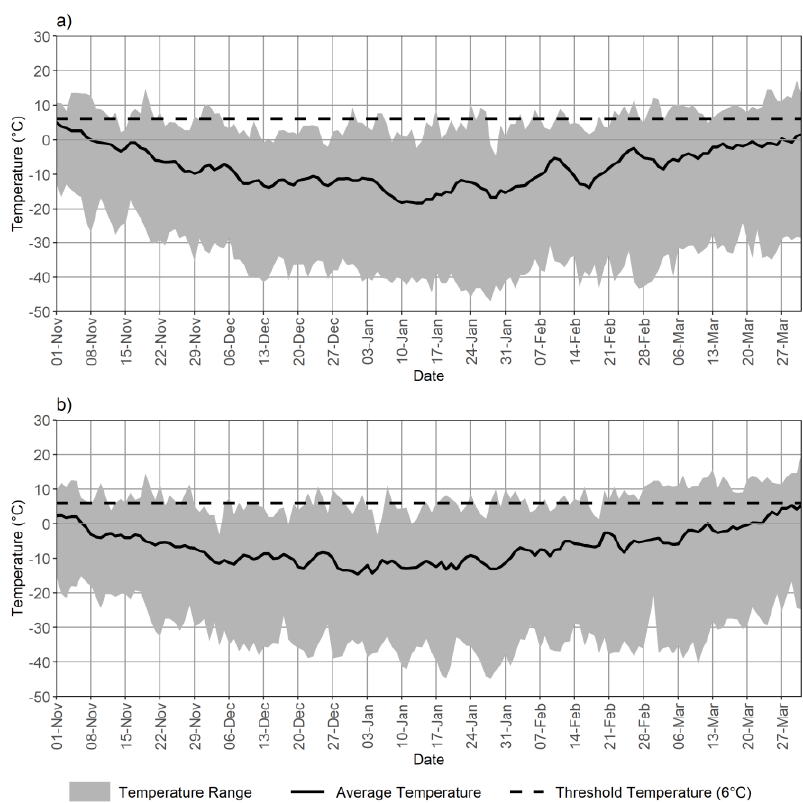
Figure 1. Range and average daily temperature for the period between ( a ) 1960 and 1980 ( b ) 1995 and 2015. The upper range is the extreme high and the lower range is the extreme low temperatures for each day of this 20 year period. Note, however, that every extreme high point above 6 °C is a shut-down day, but these did not all occur on the same year.